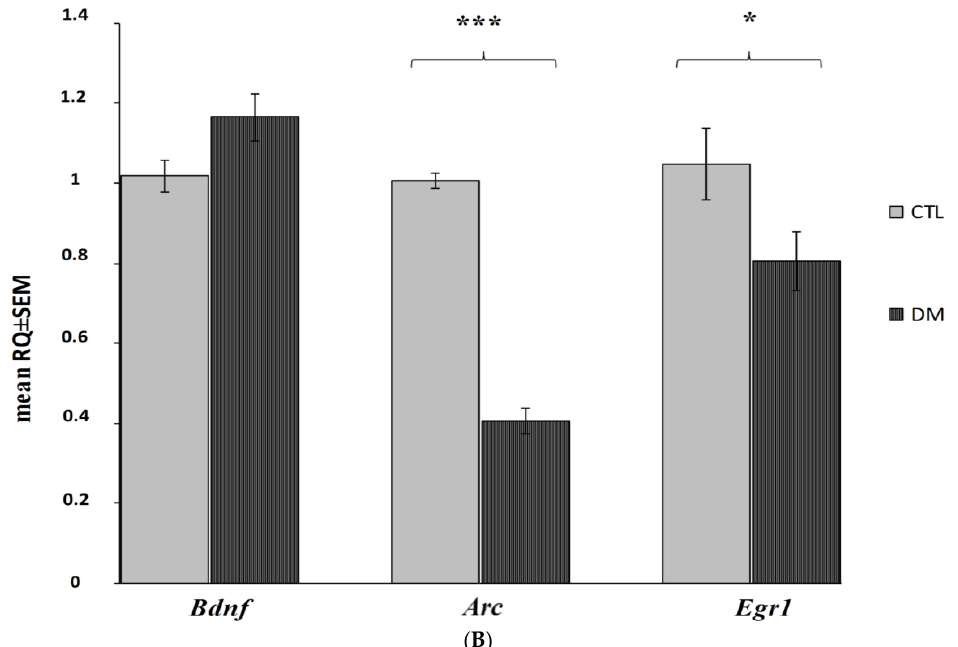
Figure 6. Changes in mRNA expression level in the prefrontal cerebral cortex and hippocampus in the analyzed in diabetic mice ( n = 6 mice per group). Data presented as RQ ± SEM. *** p < 0.001; ** p < 0.01, * p < 0.05 versus control group prefrontal cortex ( A ), hippocampus ( B ).